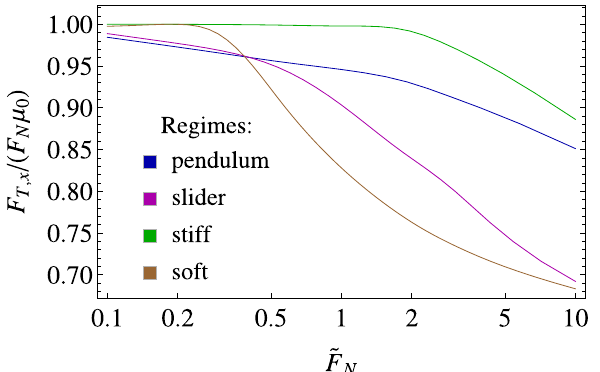
Figure 6. The normalized apparent friction force F T , x /µ 0 F N as a function of the dimensionless normal load ˜ F N acting on the rigid slab. The elastic properties corresponding to the qualitative dynamic regimes are: pendulum, k r = 3 and k θ = 0.01 ; slider, k r = 0.01 and k θ = 3 ; stiff, k r = 3 and k θ = 3 ; soft, k r = 0.03 and k θ = 0.03 . Notably µ 0 = µ( V 0 ) .